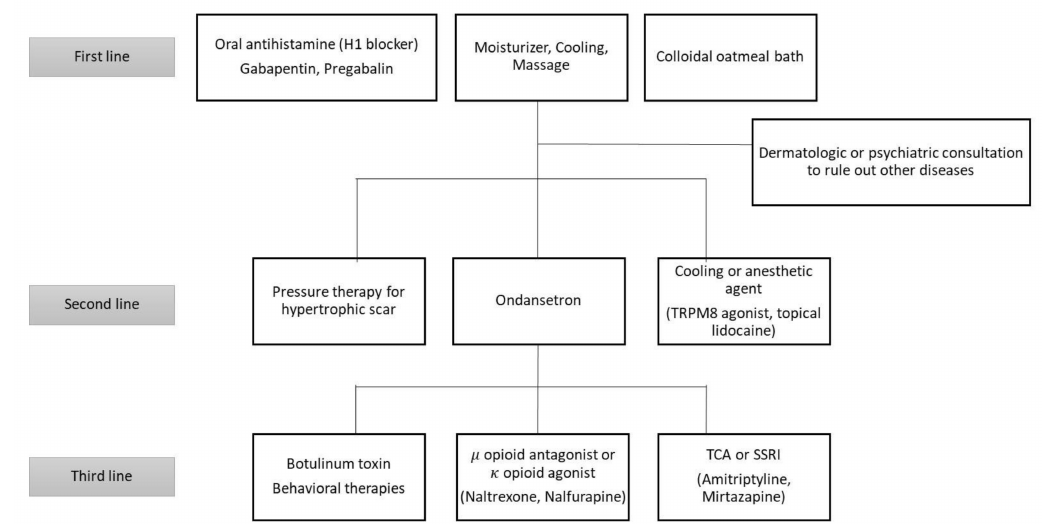
Figure 2. Algorithm of post-burn pruritus - modified treatment. Adapted from